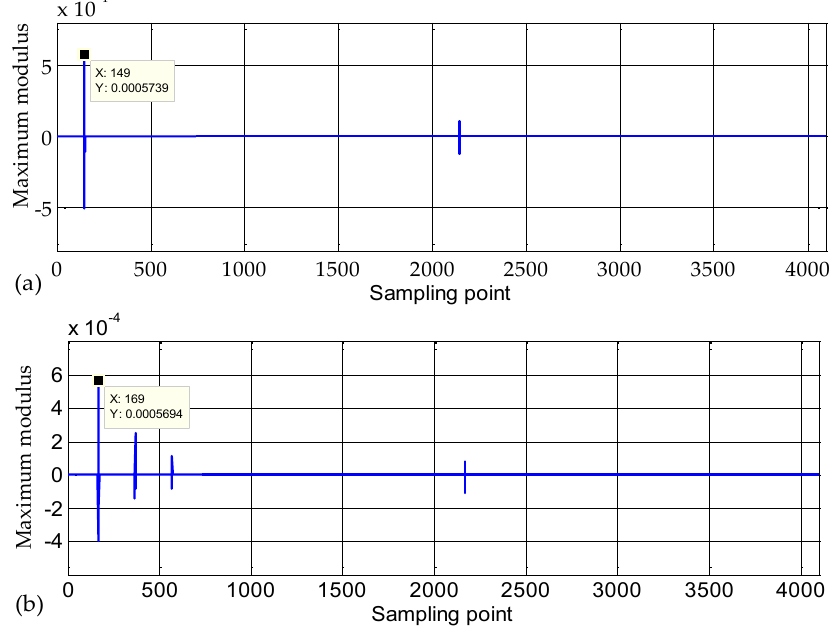
Figure 14. Decomposed result maximum modulus: ( a ) At terminal M and ( b ) At terminal N.